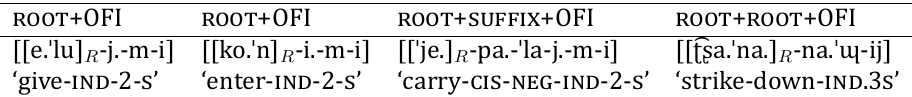
Table 15: Stress in minimally in(cid:976)lected verbs (vowel and consonant-(cid:976)inal), further suf- (cid:976)ixed verbs, and serial verb constructions